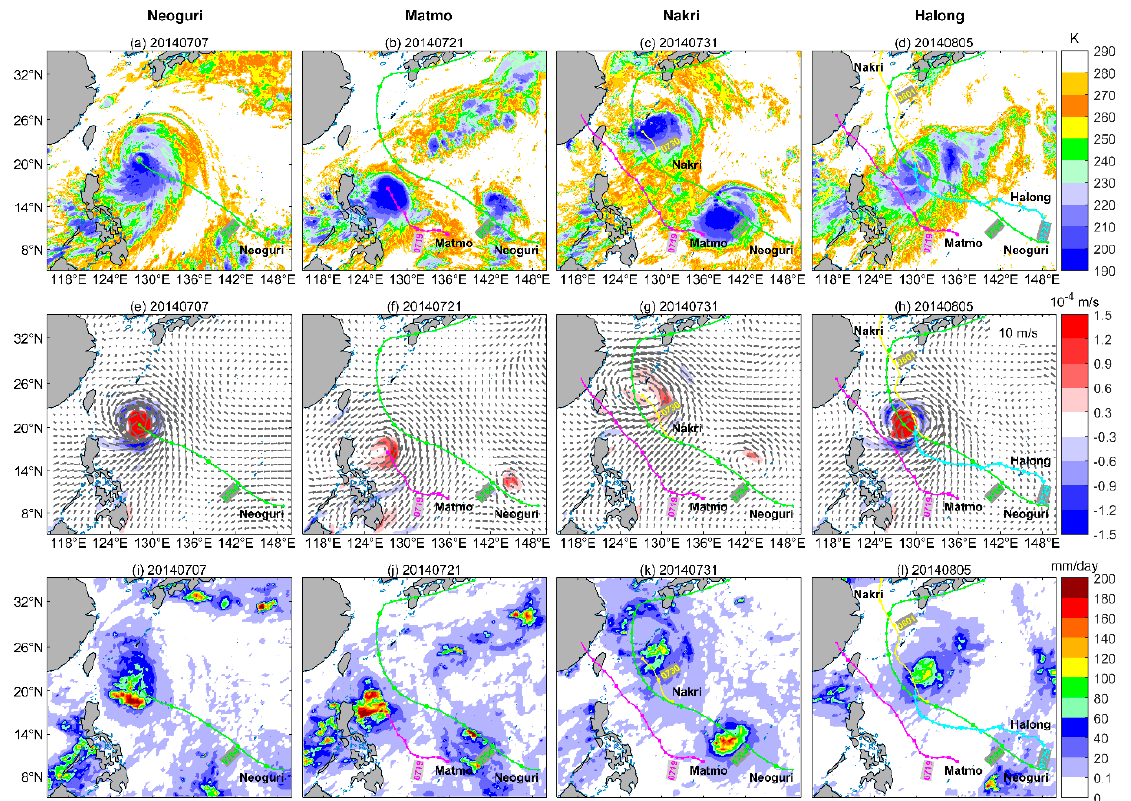
Figure 2. Evolutions of ( a – d ) cloud top brightness temperature, ( e – h ) sea surface wind and Ekman pumping velocity, and ( i – l ) rainfall distribution during the passage of sequential TCs. The colored lines represented the TC